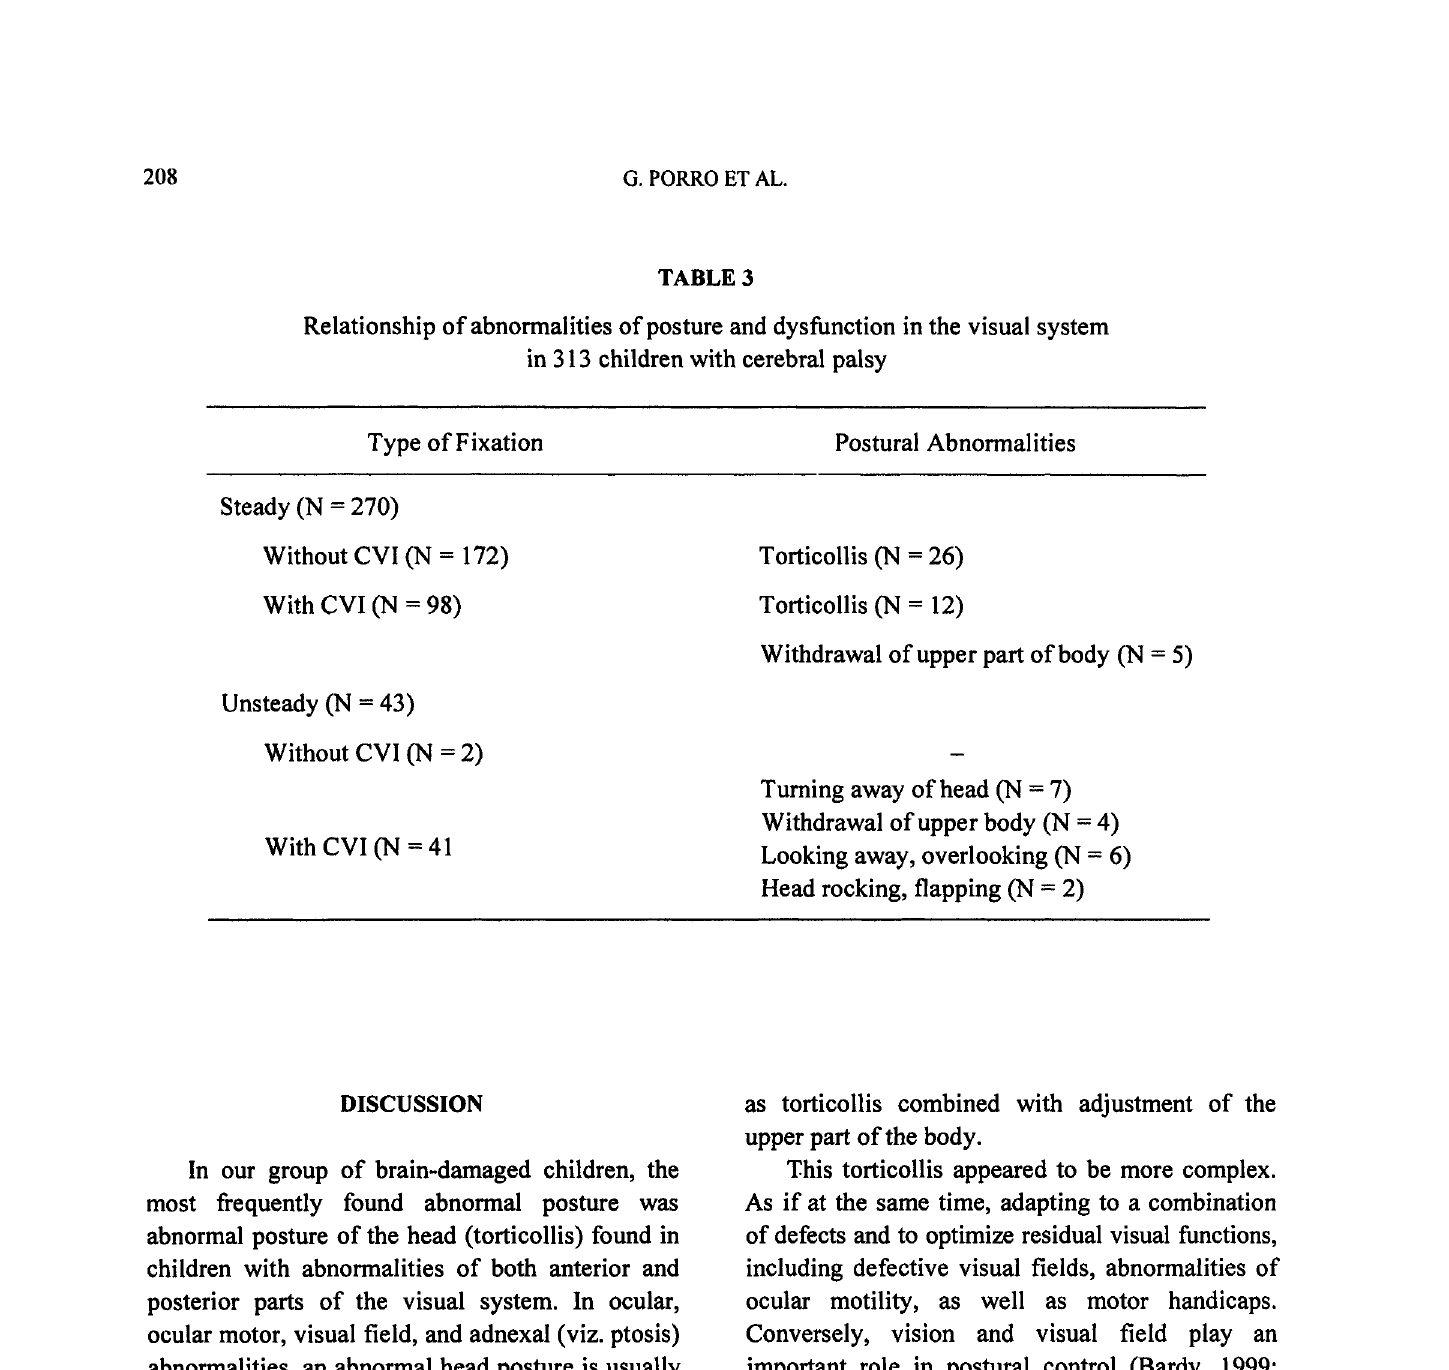
Relationship of abnormalities of posture and dysfunction in the visual system in 313 children with cerebral